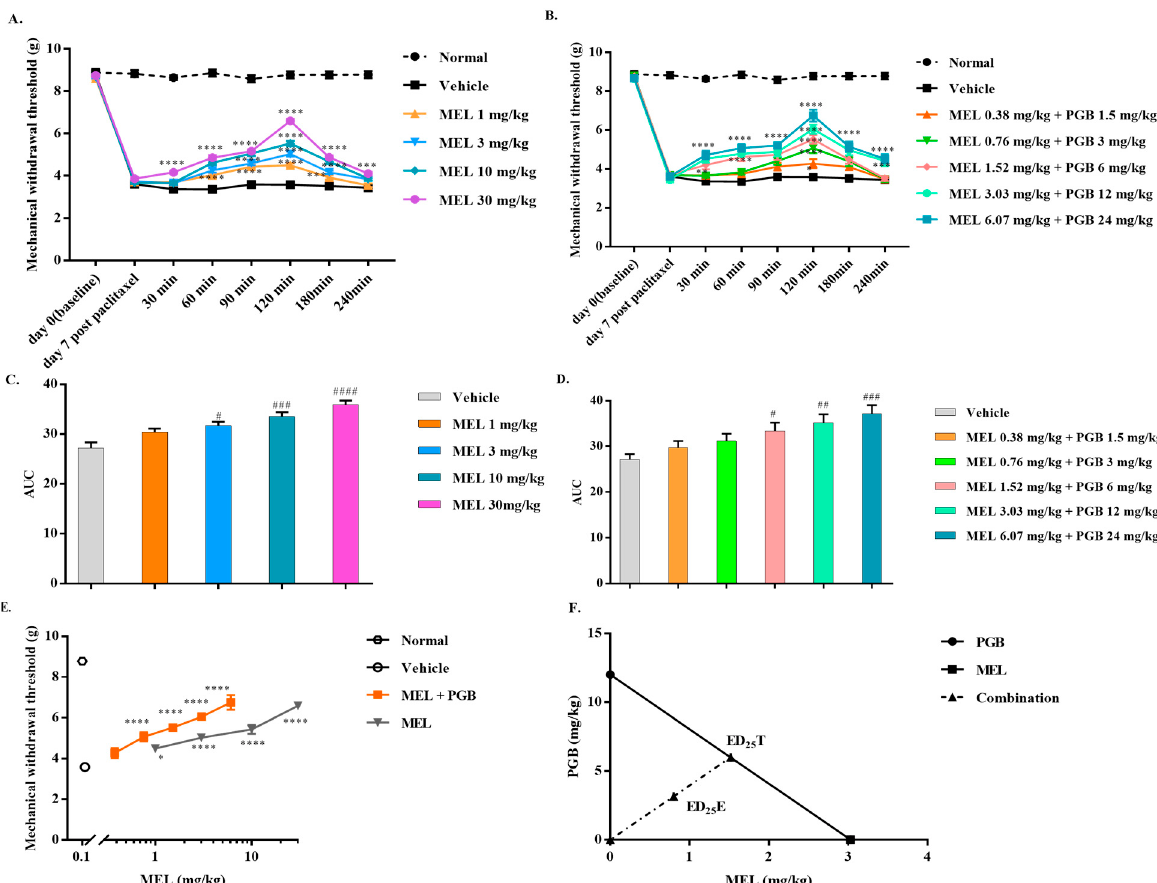
Figure 2. Effect of meloxicam (MEL), pregabalin (PGB), and MEL-PGB on paclitaxel-induced neuropathic pain in mice. Time course of the antiallodynic effects evoked by MEL and the combination of MEL and PGB ( A , B ). The AUC of MEL or MEL-PGB indicates that they reversed paclitaxel-induced mechanical allodynia in a dose-related manner ( C , D ). Equieffective doses of MEL and PGB were administered in combination to reverse mechanical allodynia in a dose-dependent manner ( E ). An equieffective combination of PGB and MEL made the dose–response curve shift to the left ( F ).